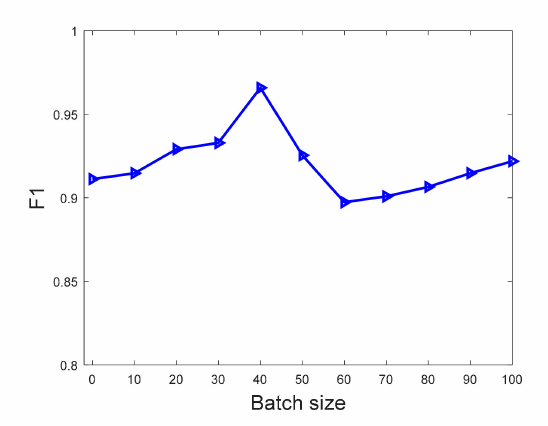
Figure 10. Curve of batch size and F1 scores.